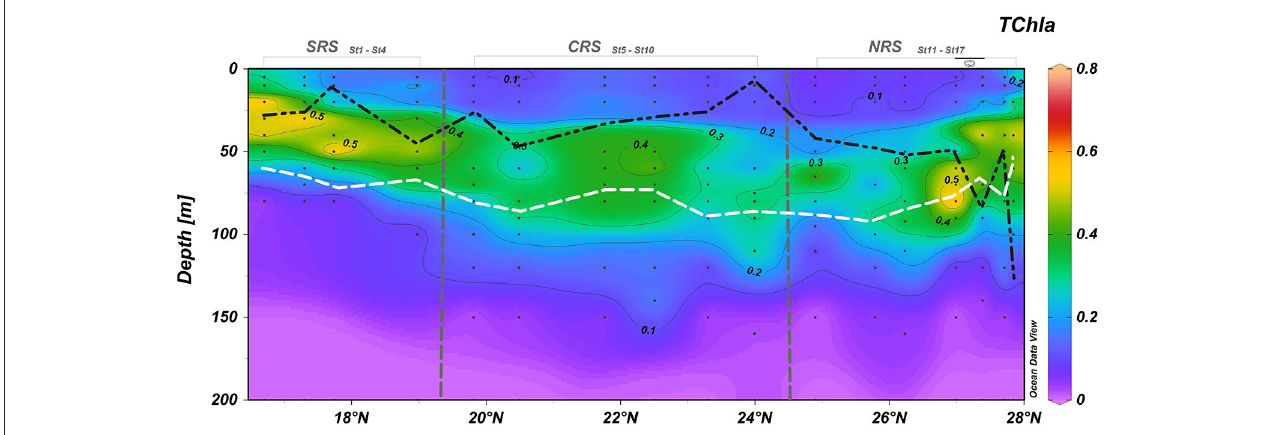
FIGURE 3 | Contour plot of the TChla concentrations (mg m − 3 ) along the the south-north transect. White and black dashed lines represent the depth of the euphotic layer, Z eu (m) and the mixed layer depth, MLD (m), respectively. Small black dots represent collected water samples at each sampling station. Eddy stations marked along the top of the upper graph.